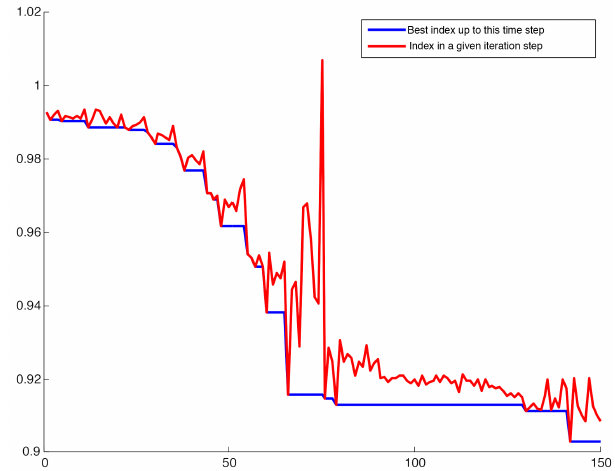
Figure 3. The change of performance index in the optimization it- erations. The x axis shows the optimization iterations. The y axis shows the improvement index in Eq. (3). The red line is the index in a given iteration step, while the blue line is the best index up to this time step.